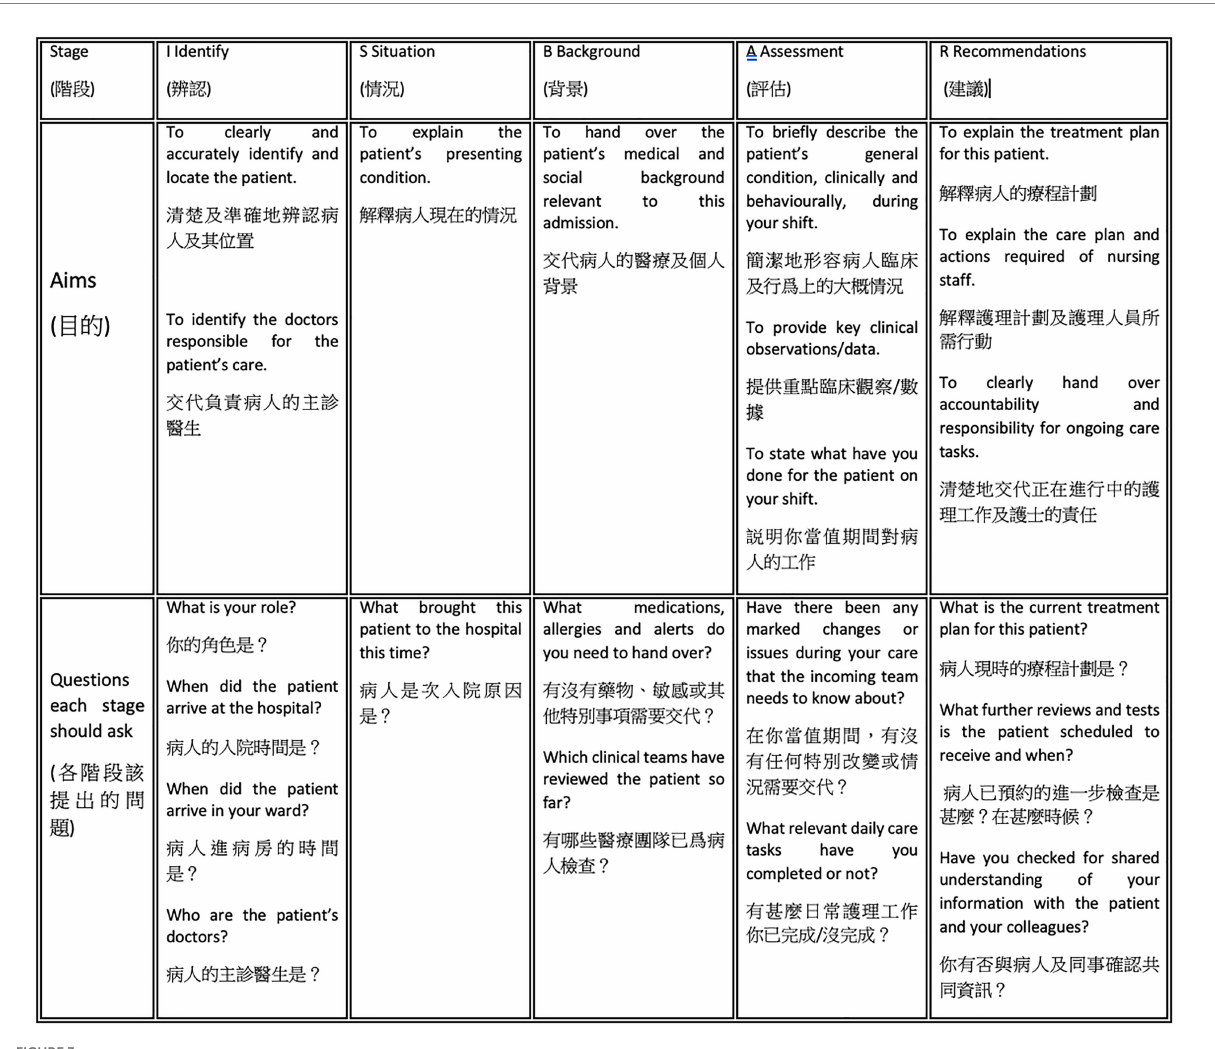
FIGURE 3 The ISBAR protocol for bilingual nursing